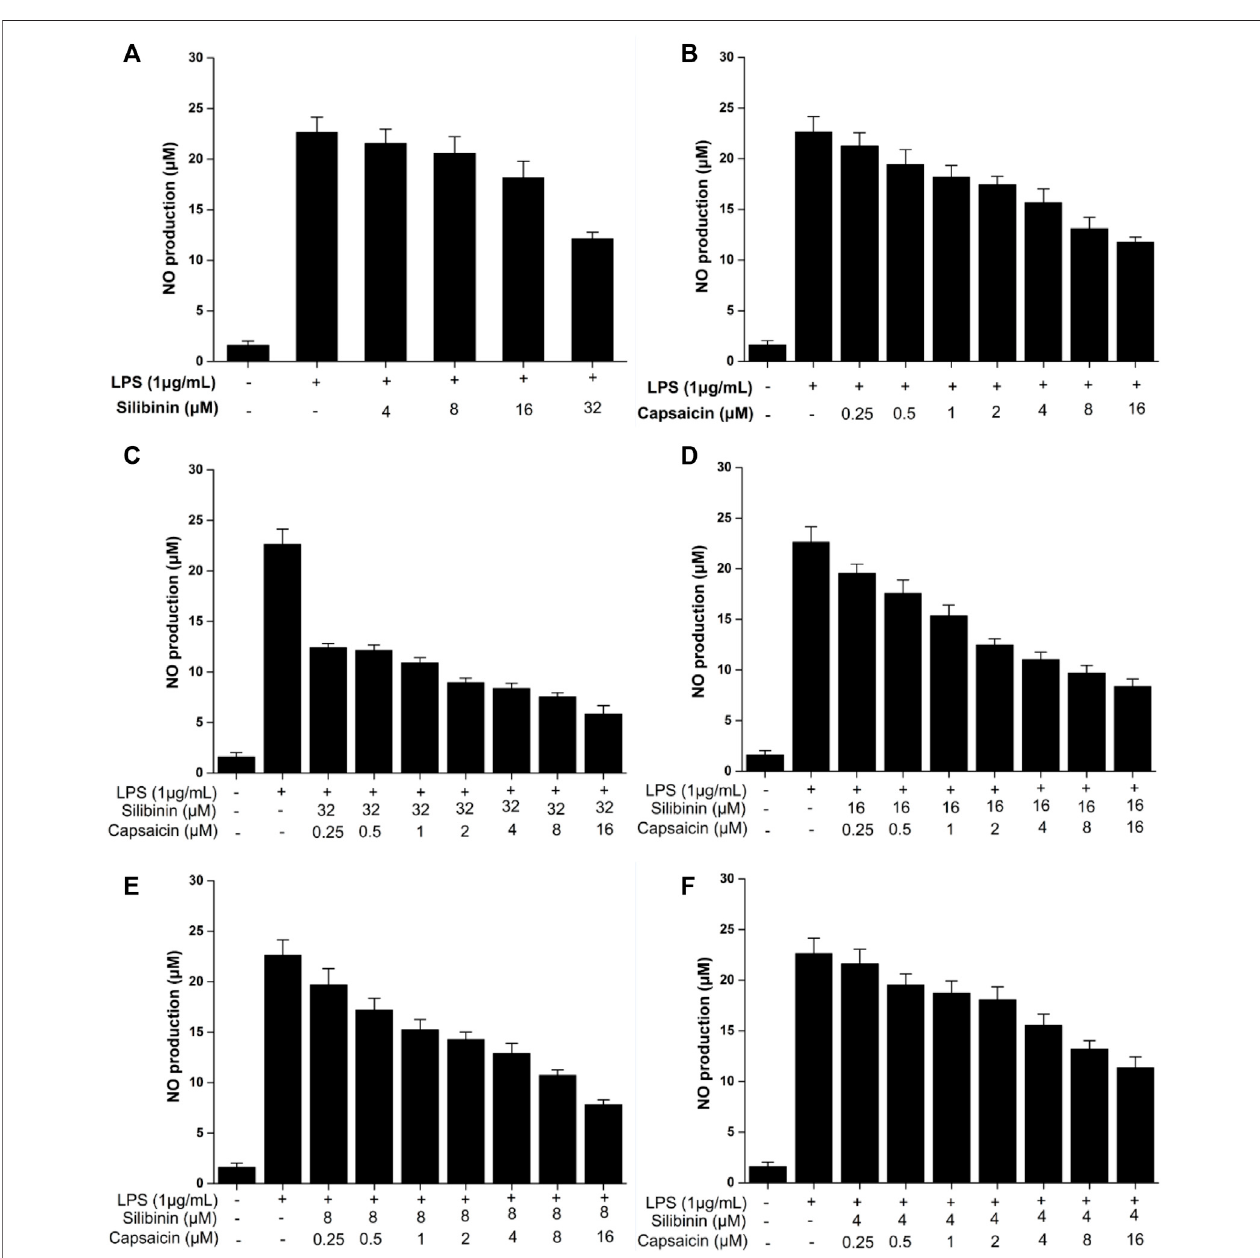
FIGURE 2 | Inhibitory effect of silibinin (4 – 32 μ M) on the LPS-induced NO (A) . Inhibitory effect of capsaicin (0.25 – 16 μ M) on the LPS-induced NO (B) . Inhibitory effectofsilibinin andcapsaicincombinationat differentconcentration ratios ontheLPS-inducedNO (C – F) .Afterbeing plated into96-wellplates and incubated for24 h, thecellsweretreatedwithsilibininand/orcapsaicinfor2 handsubsequentlyco-treatedwithLPS(1 μ g/ml)for24 h.ThemediumwasmixedwiththeGriessreagent(1:1) and placed in the dark for 15 min. Then the absorbance was measured at 540 nm.